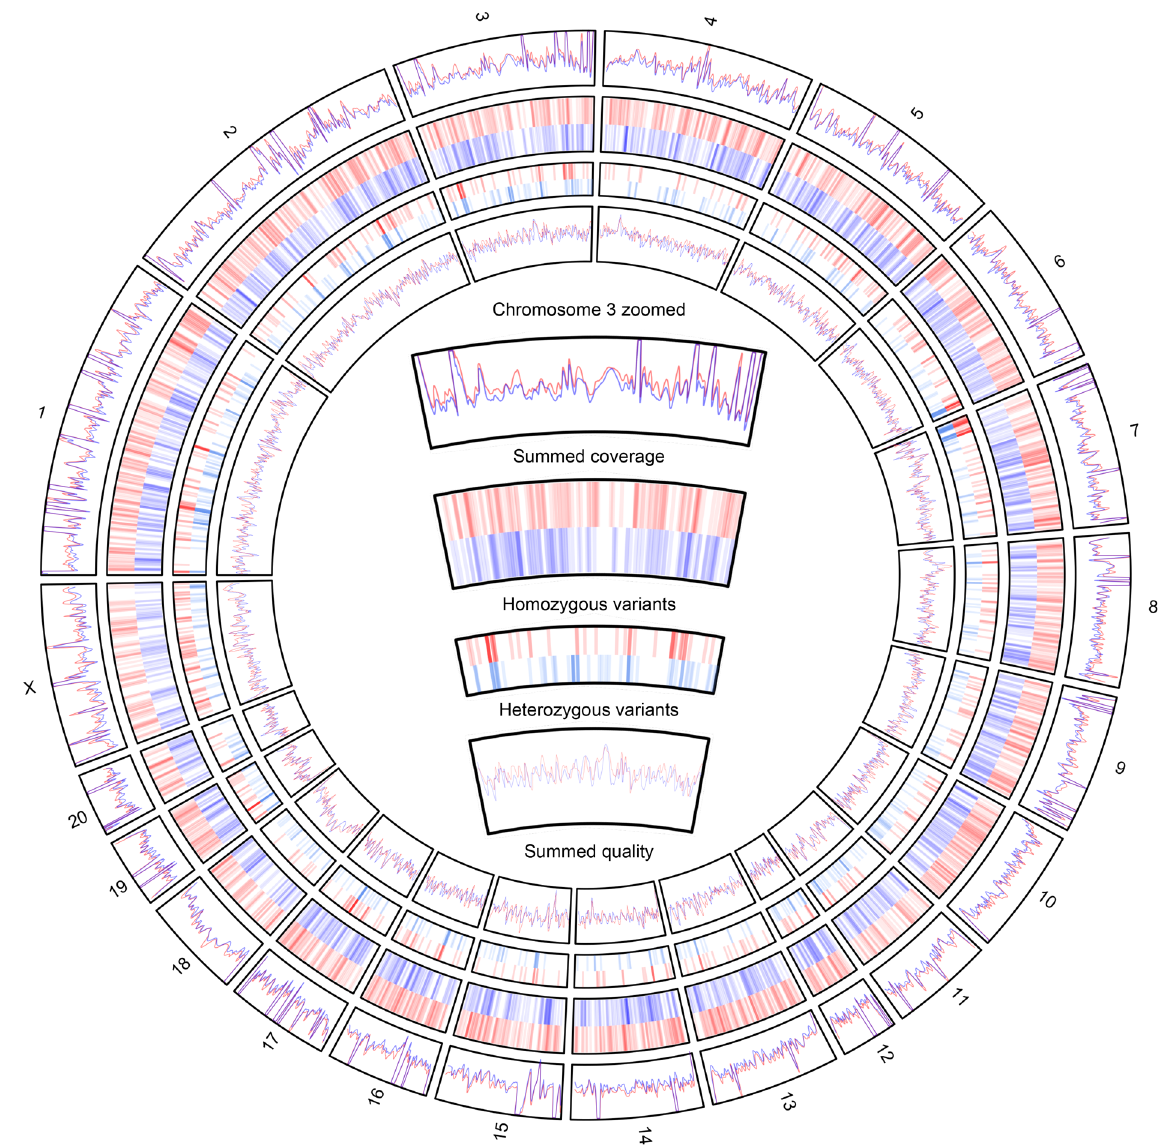
Figure 2. From outside to inside: (1) Smoothed summed coverage of variant calls per technique for WMI samples (blue) and WLI samples (red). (2) Hotspots of homozygous SNPs on each chromosome found only in WMI (Blue) or WLI (Red). (3) Hotspots of heterozygous variants on each chromosome found only in WMI (light blue) or WLI (light red). (4) Smoothed summed quality of variant calls per technique for WMI samples (blue) and WLI samples (red). * Chromosome Y excluded.